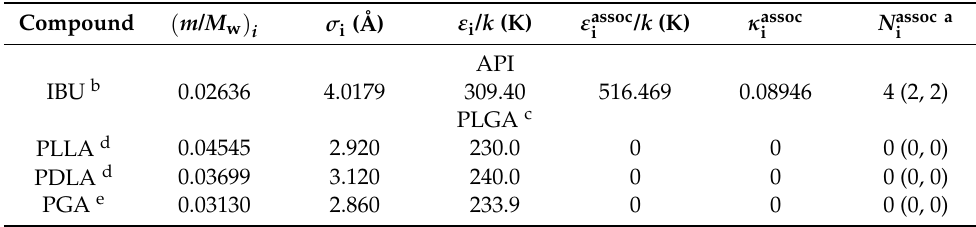
Table 1. PC-SAFT EOS pure-component parameters.